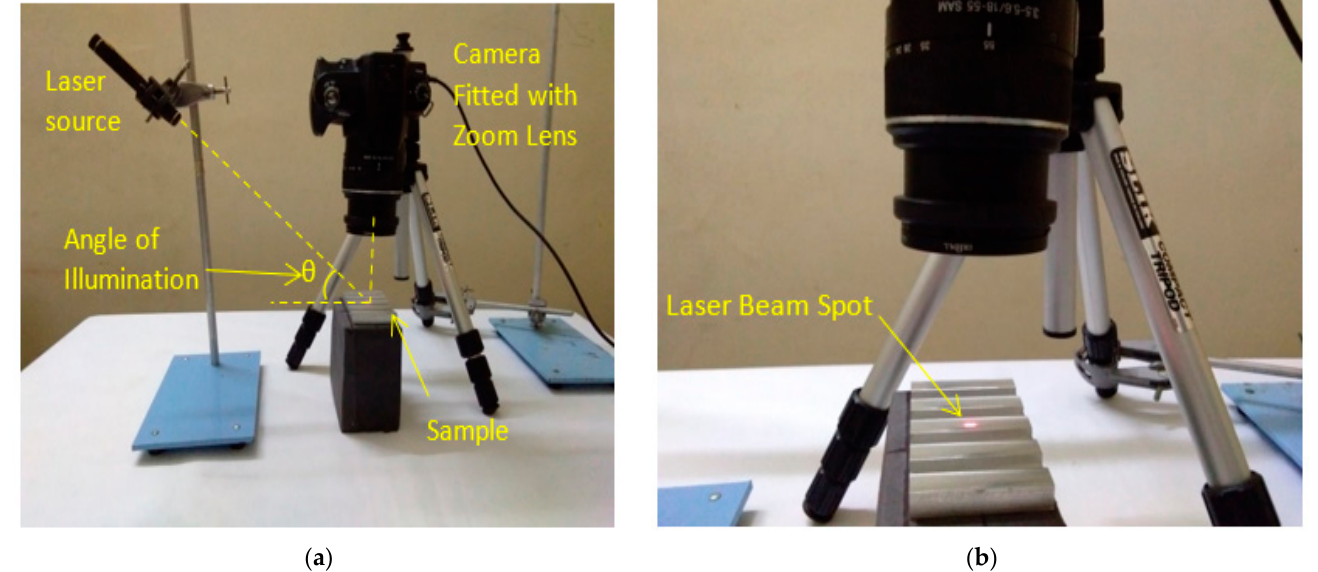
Figure 4. ( a ) Experimental setup 2 and ( b ) close-up view of the sample illuminated by laser beam [10].